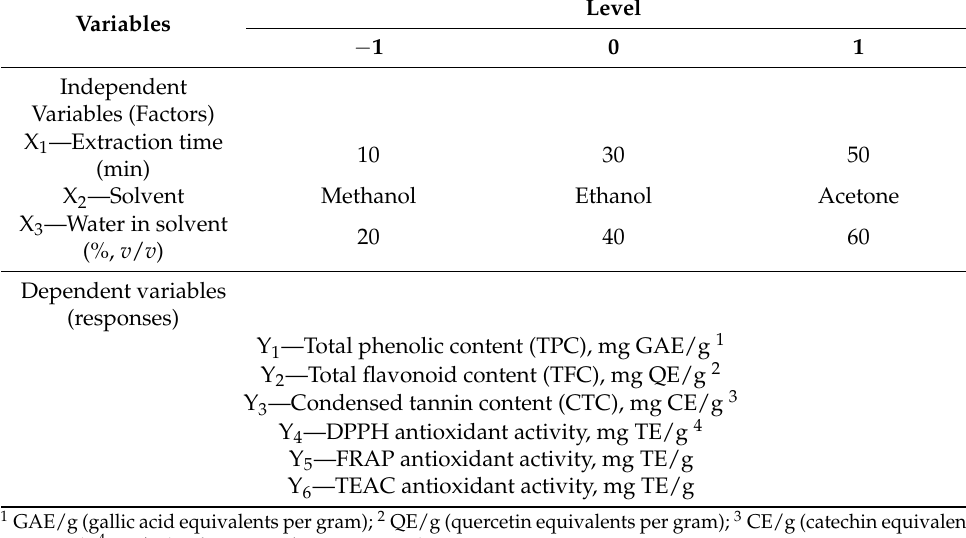
Table 1. Independent and dependent variables of the experimental